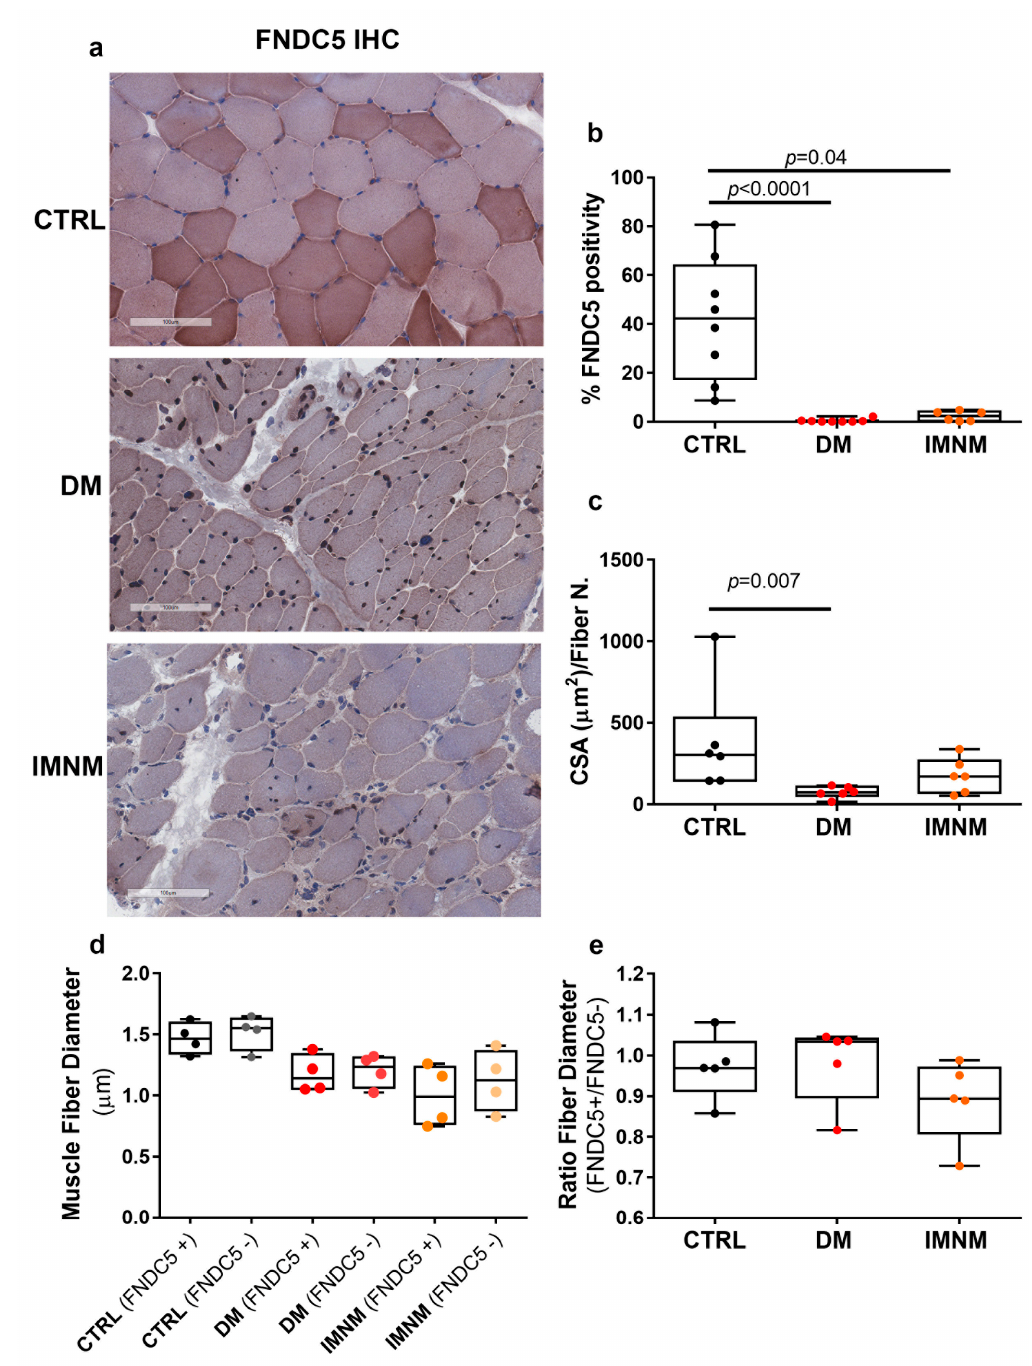
Figure 2. Representative images of immunohistochemistry staining of FNDC5 protein in muscle biopsies of control subjects (CTRL) and DM and IMNM patients (magnification: 20×) ( a ). Quantitative assessment of percentage of FNDC5 staining ( b ). Quantitative assessments of cross-sectional area (CSA) normalized to the number of fibers in muscle biopsies of control subjects (CTRL) and DM and IMNM patients ( c ). Quantitative assessments of diameters of FNDC5(+) and FNDC5( − ) fibers in muscle biopsies of control subjects (CTRL) and DM and IMNM patients ( d ) and their ratio ( e ). D’Agostino and Pearson normality test and Kruskal–Wallis test with two-group comparison by Dunn’s multiple comparisons test were performed. Data are presented as box-and-whisker plot with median and interquartile ranges from max to min with all data points shown; significant results were indicated by p value. 2.4. Irisin Levels in Patients with DM and IMNM Are Higher Than in Control Subjects